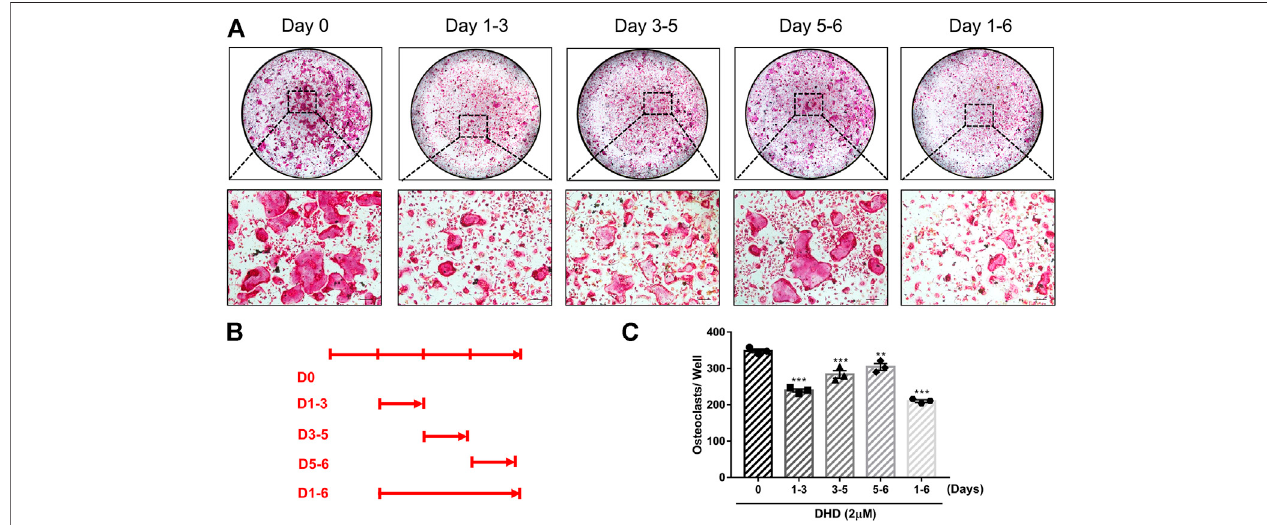
FIGURE 3 | DHD suppresses RANKL-induced osteoclastogenesis in the early, middle and later stages. (A) Representative images of TRAcP + cells treated with 2 μ MDHDatdifferenttimepoints(scalebar=200 μ m). (B) TimepointsofDHDtreatmentonBMMs. (C) Multinucleatedcells( > 3nuclei)treatedwithDHDattheindicated days were quantitatively analyzed for osteoclasts formation.